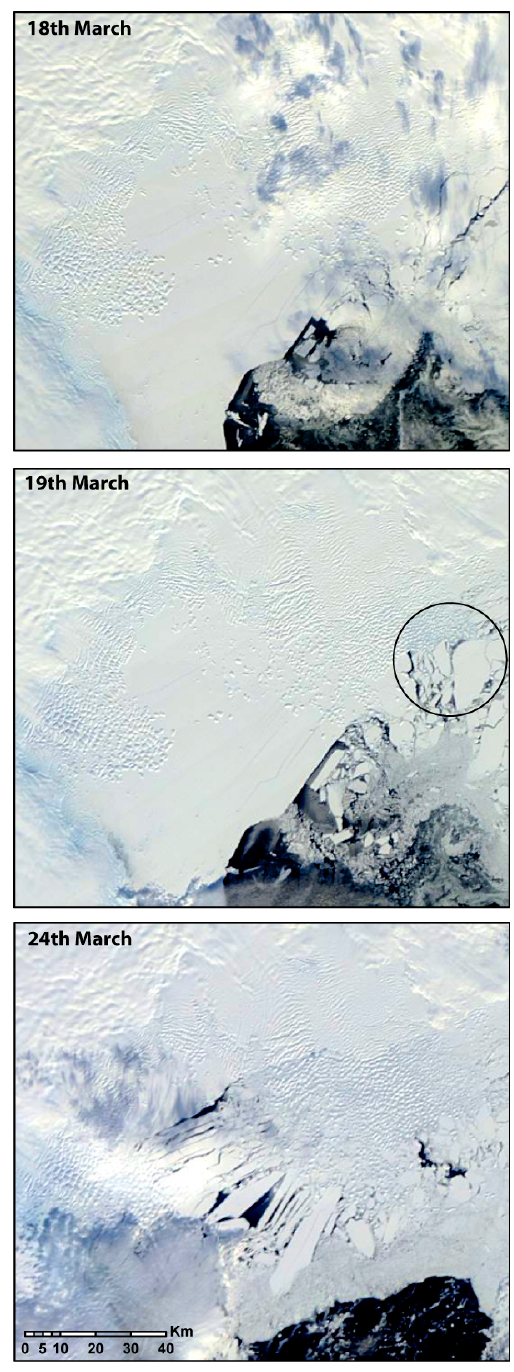
Figure 5. MODIS imagery showing the initial stages of disintegra- tion of Holmes (West) Glacier in March 2016. On 19 March a large section of sea ice breaks away from the terminus (circled), initiating the rapid disintegration process. By 24 March an 800km 2 section of Holmes (West) Glacier tongue had